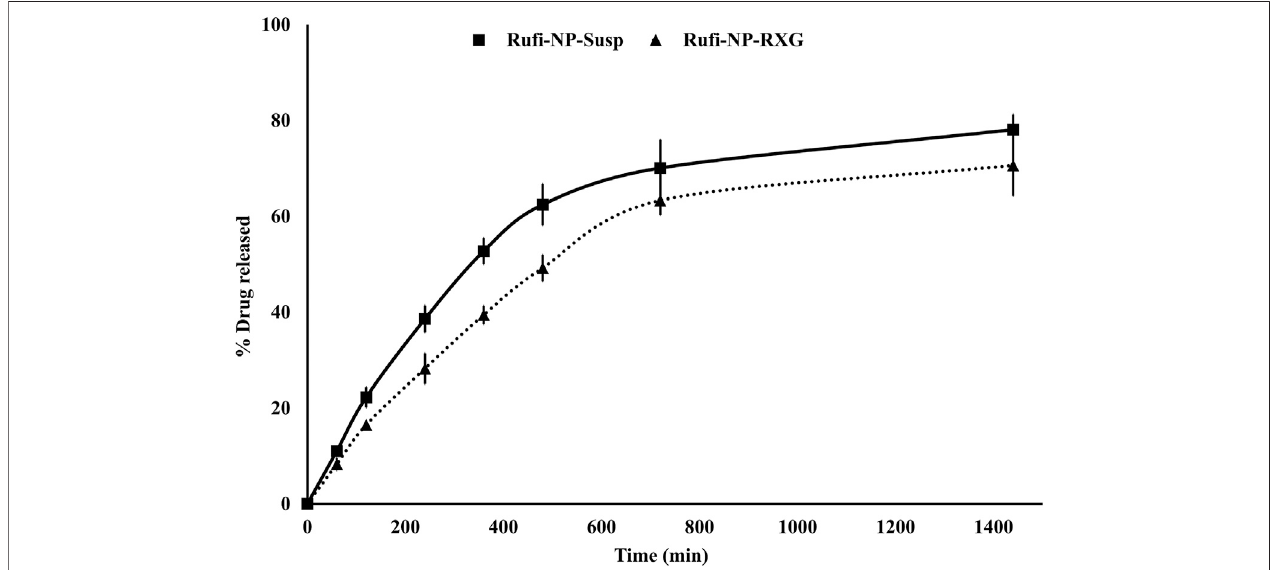
FIGURE4 | In vitro drug release pro fi les of Ru fi -NP-Susp and Ru fi -NP-RXGin simulated nasal electrolyte solution (SNES). Note: Each datapoint isamean ± SD of three independent observations ( n (cid:2) 3).